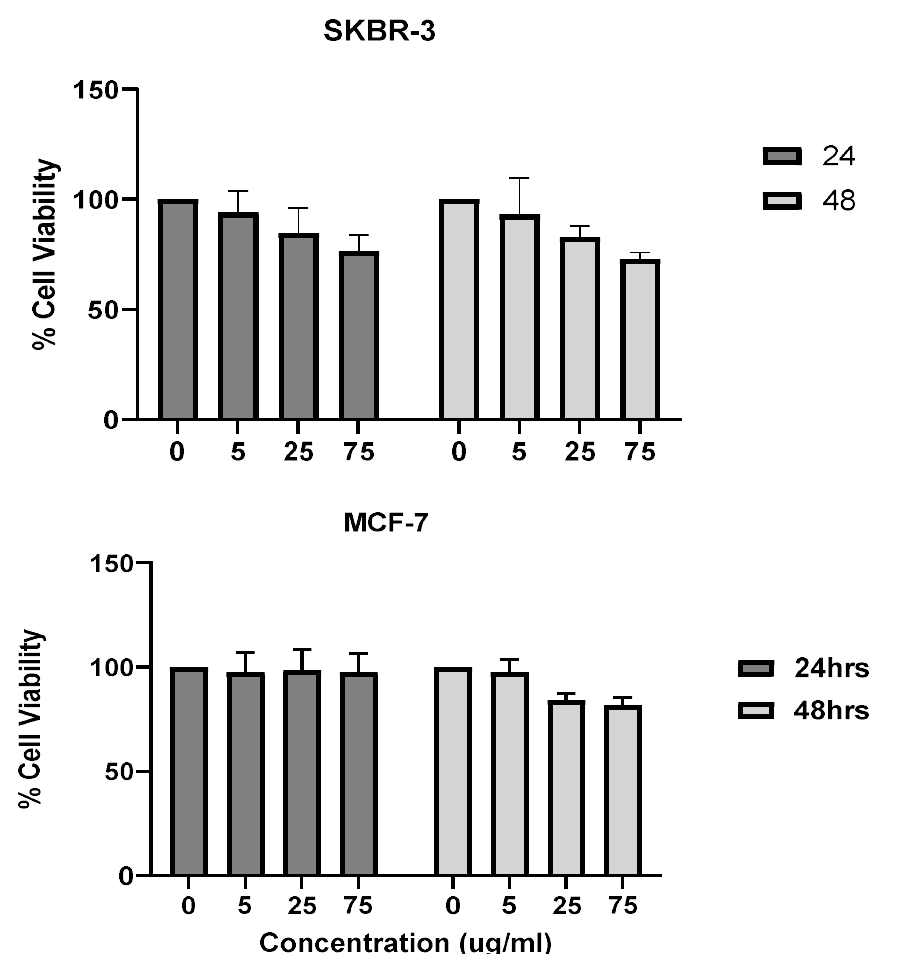
Figure 2. Cytotoxicity analysis (MTT method) of gold nanorods in concentrations ranging from 0 to 75 µ g/mL at 24 h and 48 h in SKBR-3 cells ( top ) and MCF-7 cells ( bottom ). The SKBR-3 cells began to show a decrease in viability at 75 µ g/mL and 48 h of exposure, while MCF-7 cells showed no decrease in cell viability. No statistically significant difference in cell viability was observed. The values shown are averages with standard errors, determined from at least three independent experiments, each conducted in triplicate.